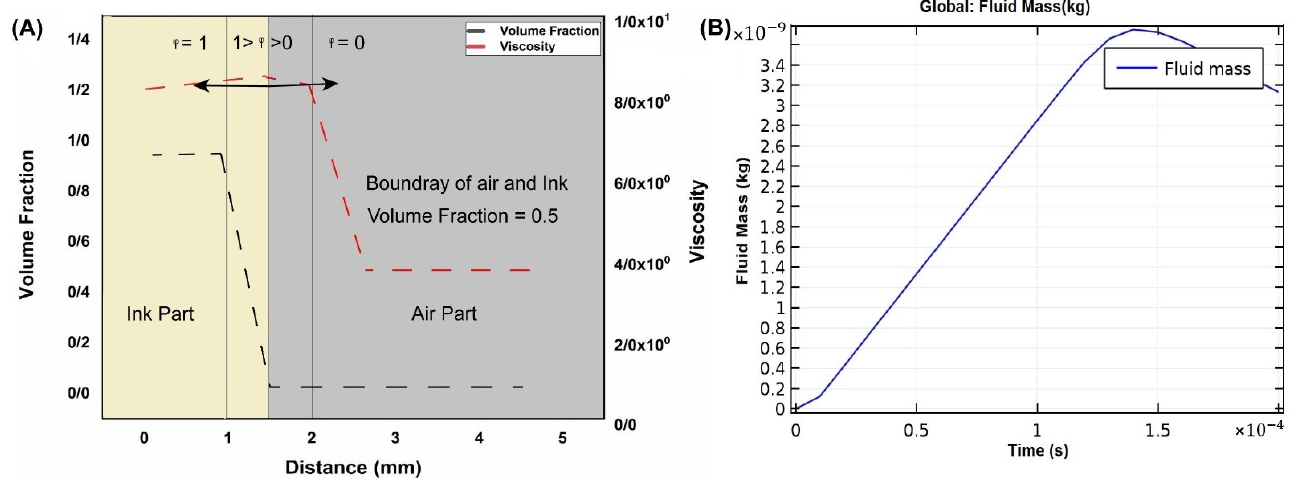
Figure 5. ( A ) Illustrated is the volume fraction and viscosity during chitosan 3D printing; ( B ) description of the mass fluid ink during simulation of chitosan 3D printing.